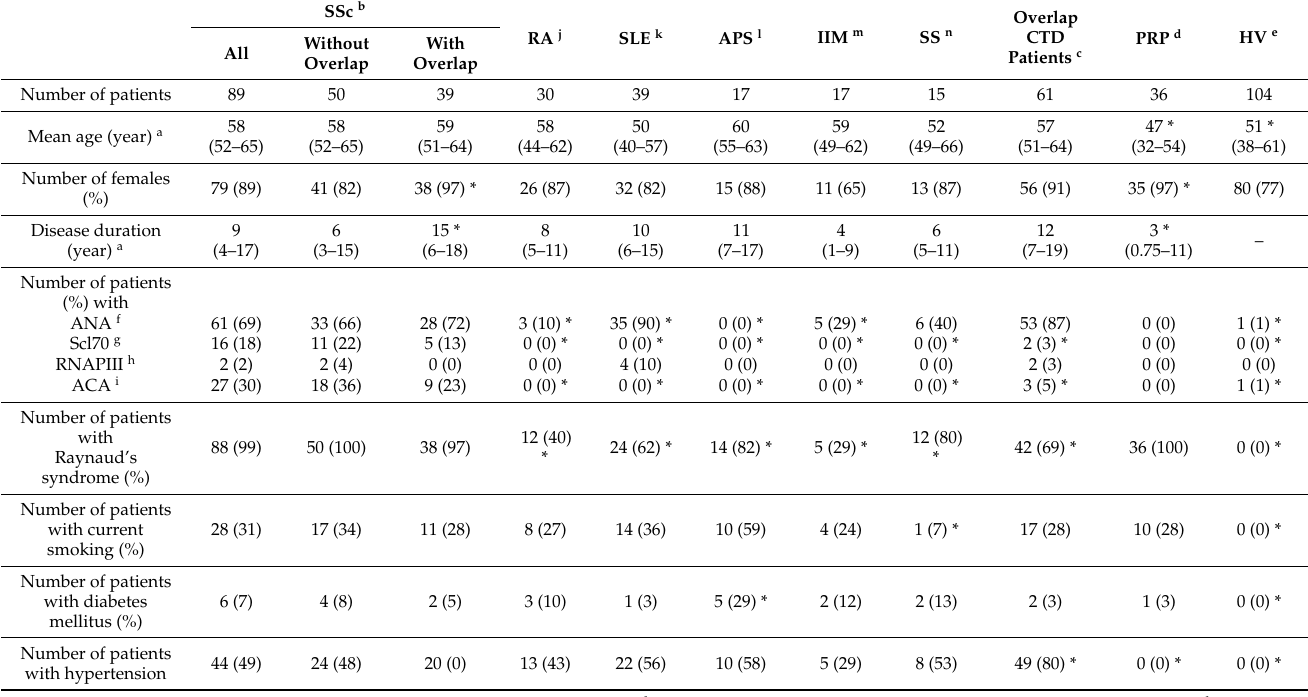
Table 1. Clinical and laboratory findings of 418 investigated